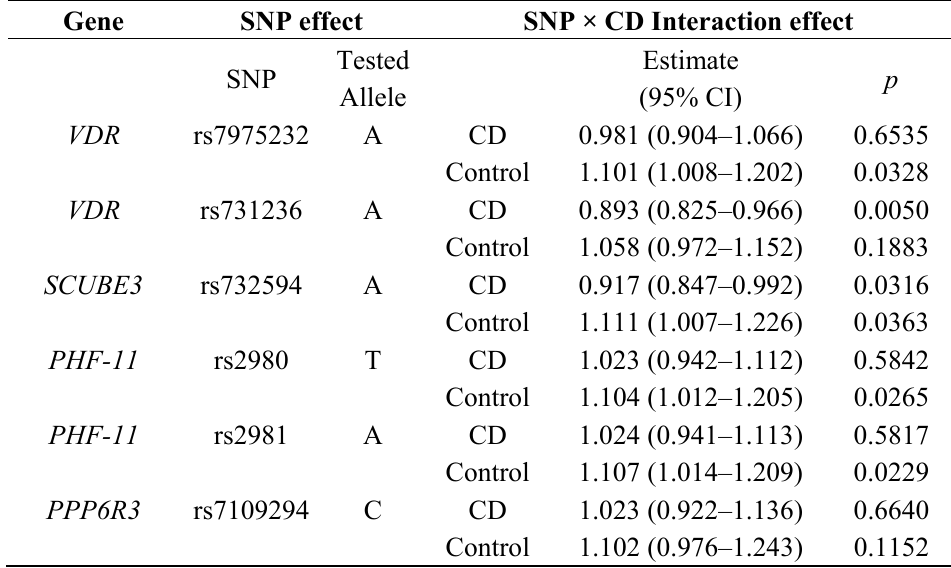
3. Gene-Crohn’s Disease interaction on vitamin D after adjustment for confounding variables